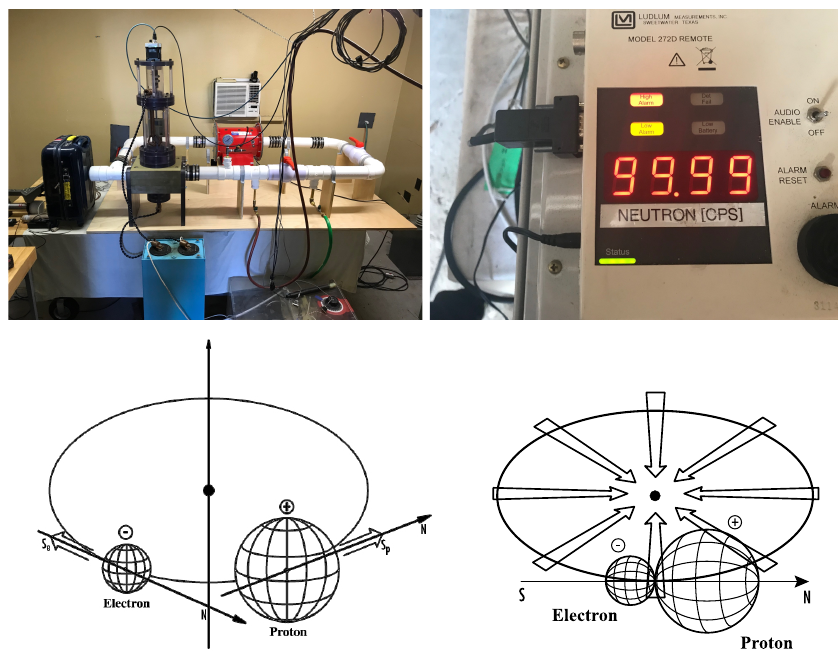
Figure 9: In this figure we show: 1) At the top left a picture of the Directional Neu- tron Source (DNS) developed by Santilli at Thunder Energies Corporation, now Hadronic Technologies Corporation [39] which synthesizes on demand neutral and negatively charged hadrons from a hydrogen gas with preferred directionality, energy and flux; 2) At the top right a typical case of neutron CPS; 3) At the bottom left a conceptual rendering of the ionization of the hydrogen gas by the electric arc during its activation and the proper axial alignment of the proton and electron with opposite charge and magnetic polarities; and 4) At the bottom right a conceptual rendering of the “compression” of the electron inside the proton by the electric arc during its